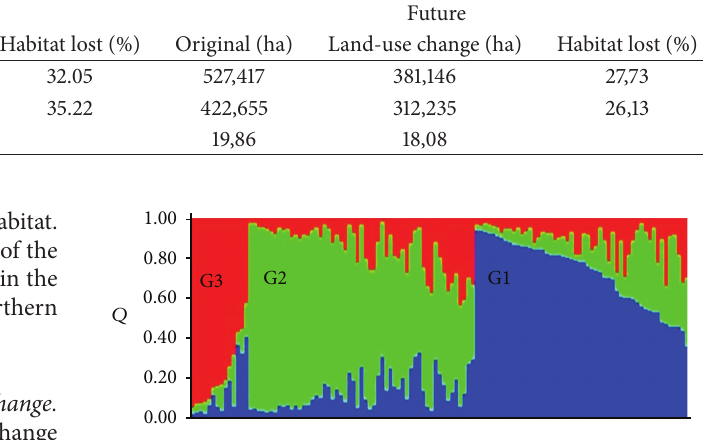
Figure 3: Bar plot of 𝑄 values for 121 P. splendens individuals analyzed by Structure Software. Three clusters 𝑘 are shown. Blue cluster (G1) included 23 individuals; green cluster (G2) included 19 individuals; and red cluster (G3) contained 9 individuals. 70 individuals of P. splendens did not pertain to any of the three clusters ( 𝑄 values <